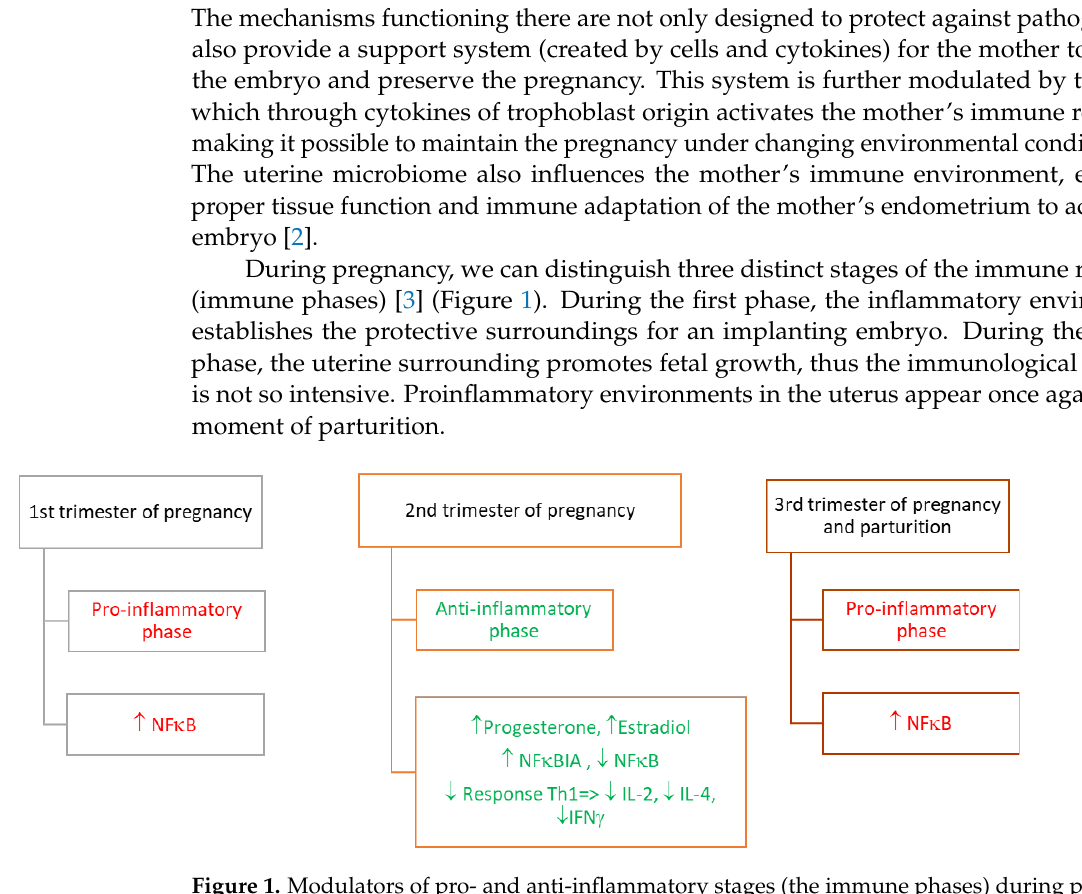
Figure 1. Modulators of pro- and anti-inflammatory stages (the immune phases) during